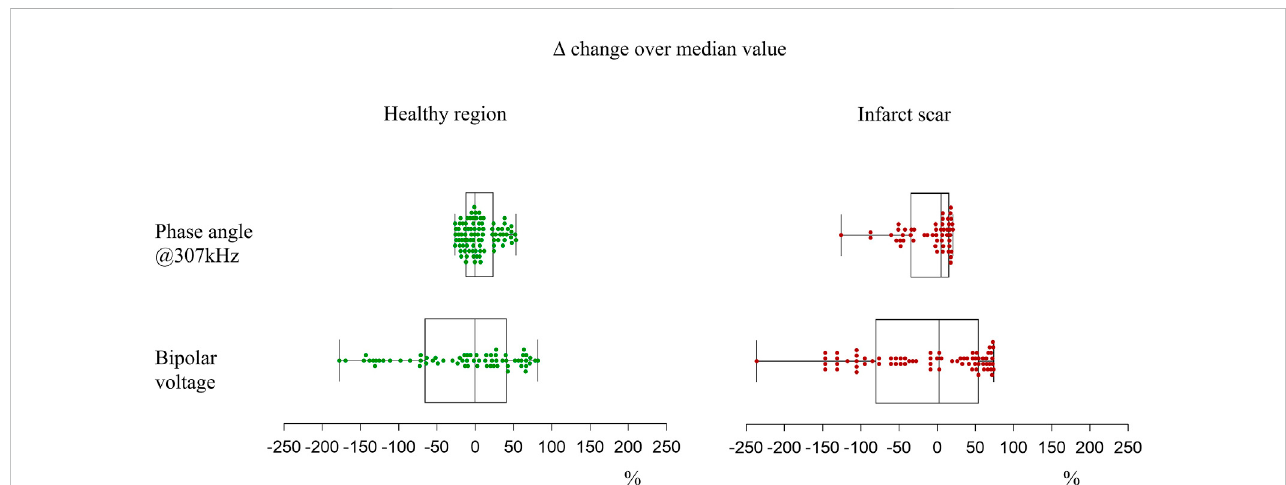
FIGURE 5 Variability of median values of phase angle of atrial tissue electrical impedance at 307 kHz and bipolar voltage of local atrial electrograms. Data are represented in box and whisker plots. Boxes represent 25th to 75th quartiles; horizontal lines within boxes represent the median; whiskers represent the minimum and maximum